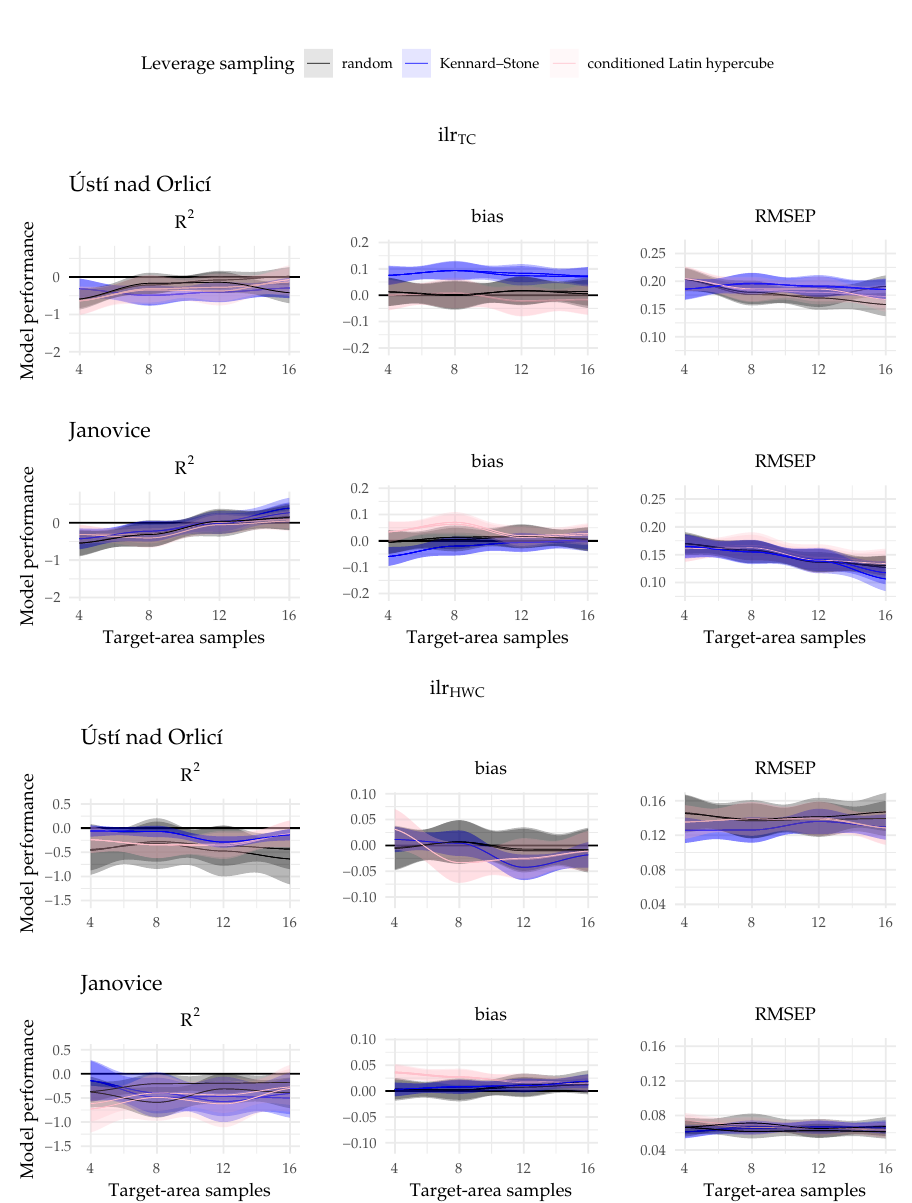
Figure 10. The influence of sampling intensity and leverage sampling on predictive local-only model performances. Only scenarios with basic and no further spectra pre-processing are included. Each line represents an ensemble of either partial least squares 2 regression (PLSR2) models or canonical partial least squares regression (CPLSR) models with the same level of spike sample weights. A mean across 10 test datasets is drawn along with its 95% confidence